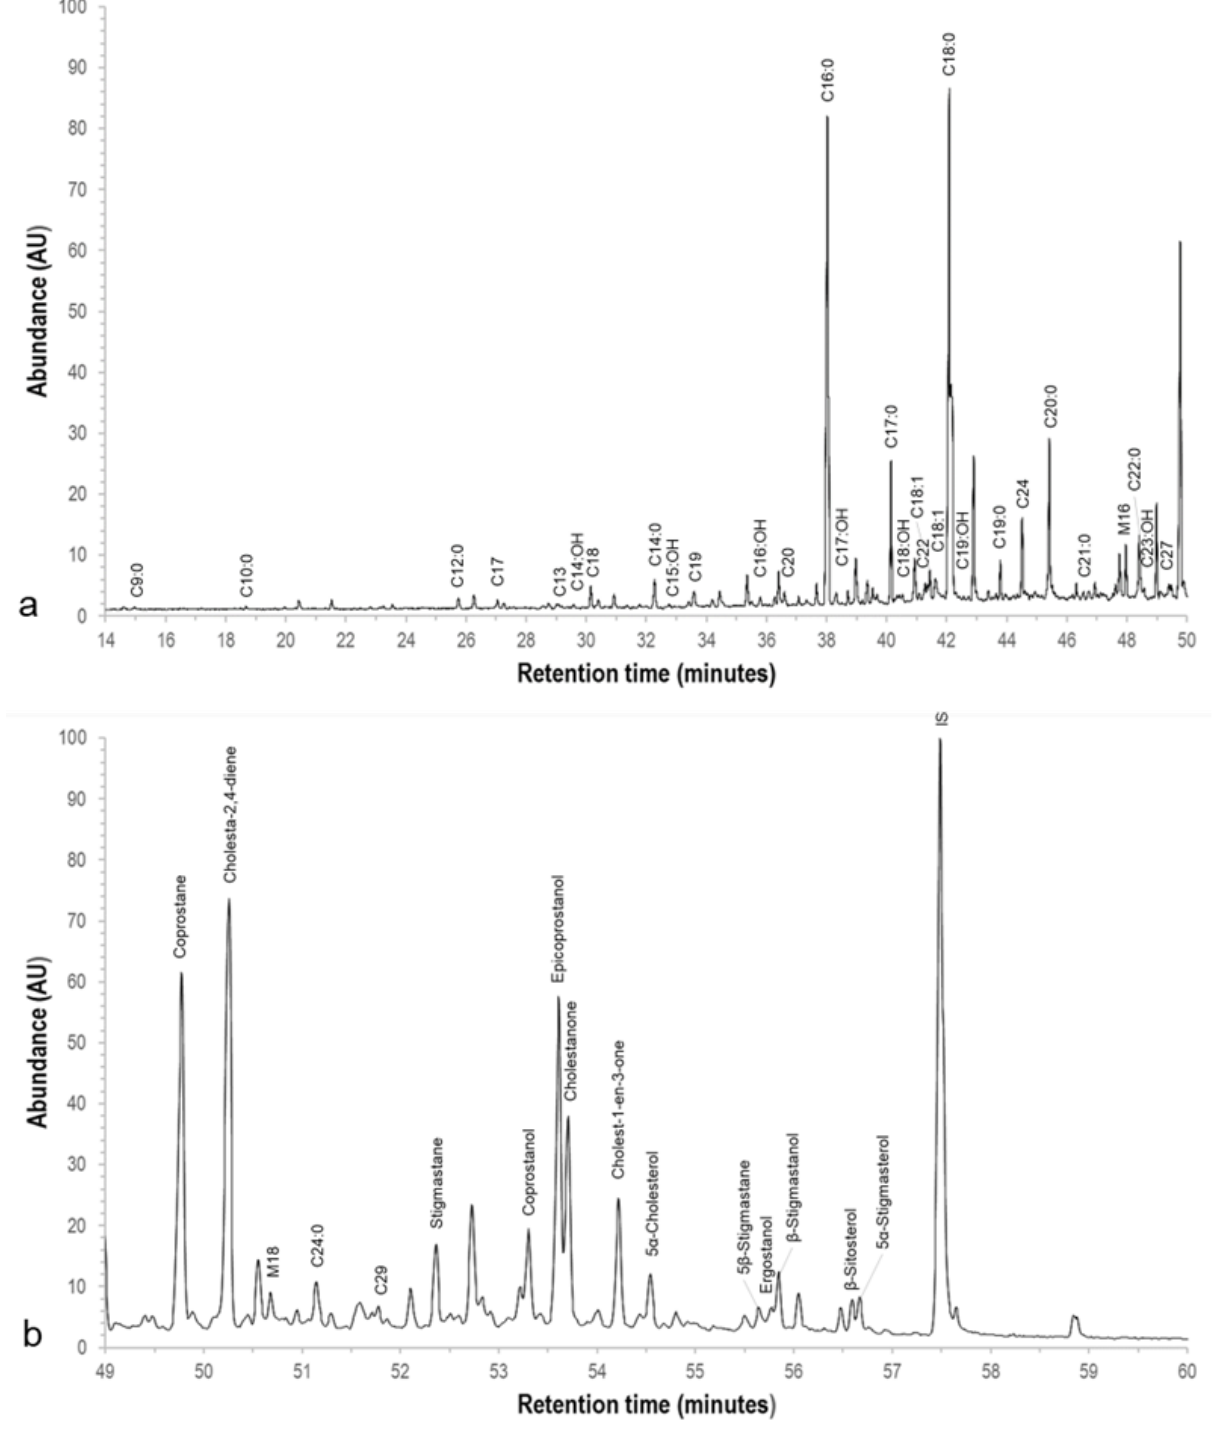
Figure 5. GC-MS chromatogram of organic residue, divided into 2 segments. ( a ) from 14–50 min; ( b ) from 49–60 min. Marked are the trimethylsilyl (TMS) derivatives of relevant compounds detected. Cx alkane with x carbon atoms, Cx:OH linear alcohol with x carbon atoms, Mx monoacylglycerol with x carbon atoms, Cx:y fatty acid with x carbon atoms and y double bonds, IS internal standard.